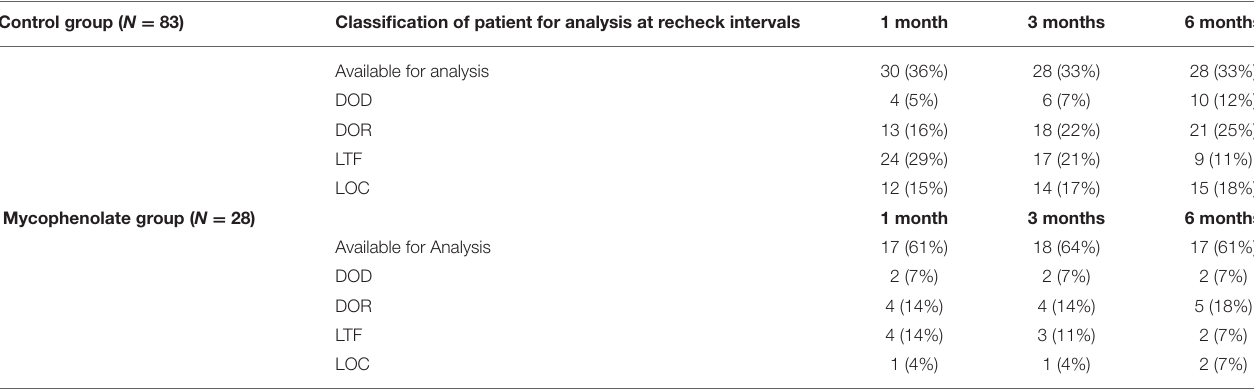
TABLE 3 | Outcome classification at 1, 3, and 6 months including due to death from respiratory disease (DOD), death for any other reason (DOR), loss to follow-up (LTF), and lack of owner compliance (LOC). Control group ( N = 83)